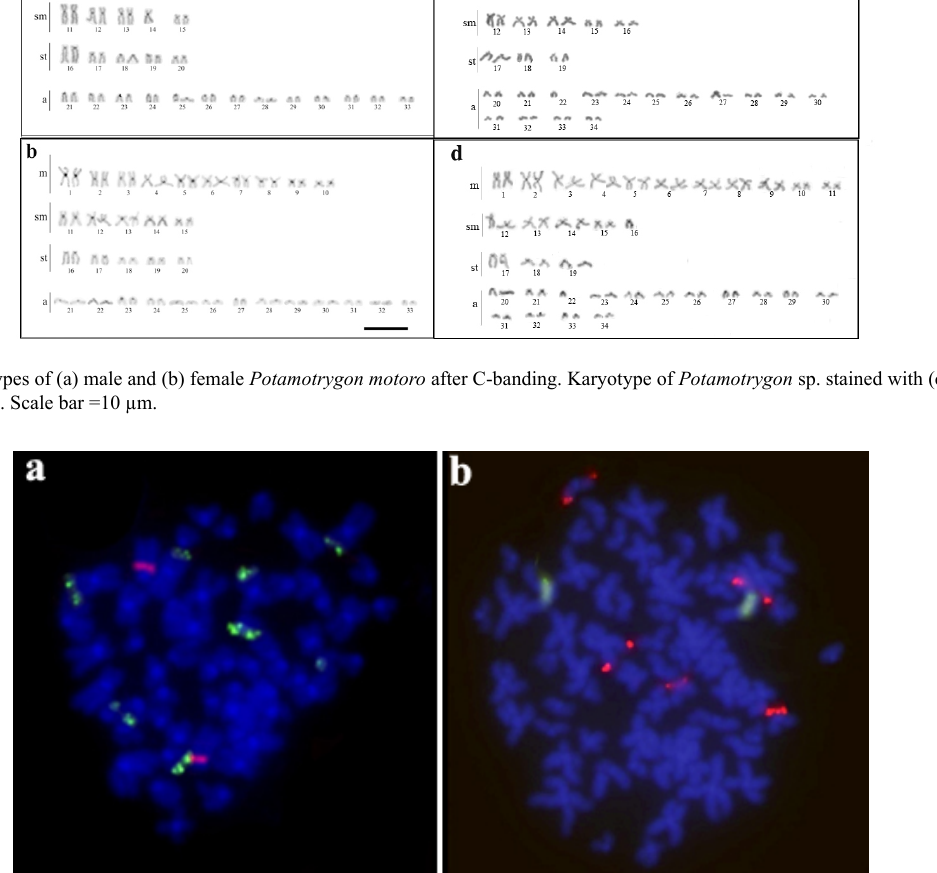
were absent in submetacentric pair 16 and pair 22 (Figure